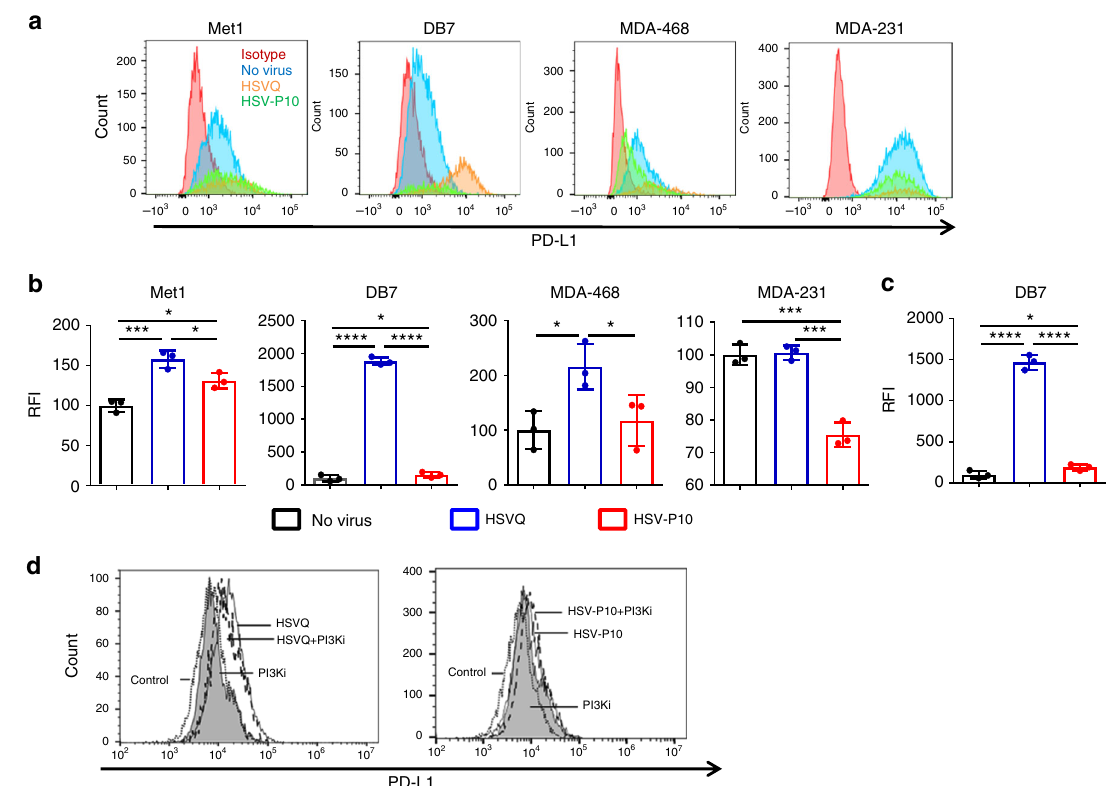
Fig. 7 HSV-P10 reduces cell-surface PD-L1 expression. a Histograms of PD-L1 expression as measured by fl ow cytometry 16 hpi in a panel of human and mouse cancer cell lines. Gates were placed on live cells, and then for GFP positive cells. Relative fl uoresence intensity was calculated based upon PD-L1 stain. Red histogram: isotype control, blue histogram: no virus, orange histogram: HSVQ, green histogram: HSV-P10. b Quanti fi cation of relative median fl uorescence intensity (RFI) of the indicated cells treated with no virus, HSVQ or HSV-P10 and stained with PDL-1 antibody where statistical signi fi cance was assessed by one-way ANOVA ( n = 3/group, * p < 0.05, *** p < 0.001, **** p < 0.0001). c Changes in PD-L1 expression ( ± s.d.) on uninfected (GFP negative) DB7 cells following low-MOI infection with either HSVQ or HSV-P10 where statistical signi fi cance was assessed by one-way ANOVA ( n = 3, * p < 0.05, **** p < 0.0001). Gates were placed on live cells, and then for GFP negative cells. Relative fl uoresence intensity was calculated based upon